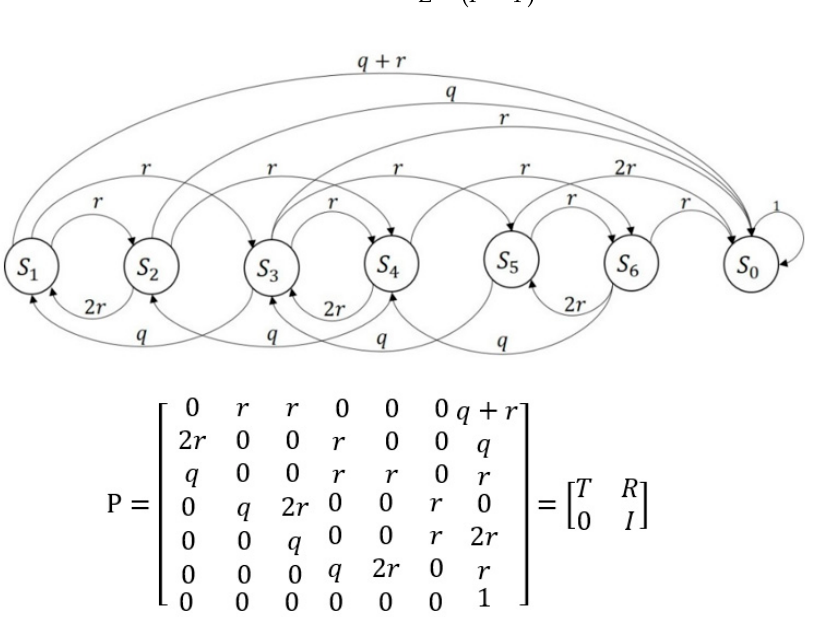
Figure 9. State transition diagram and state transition probability matrix when absorbing state 0 is introduced ( n = 9).